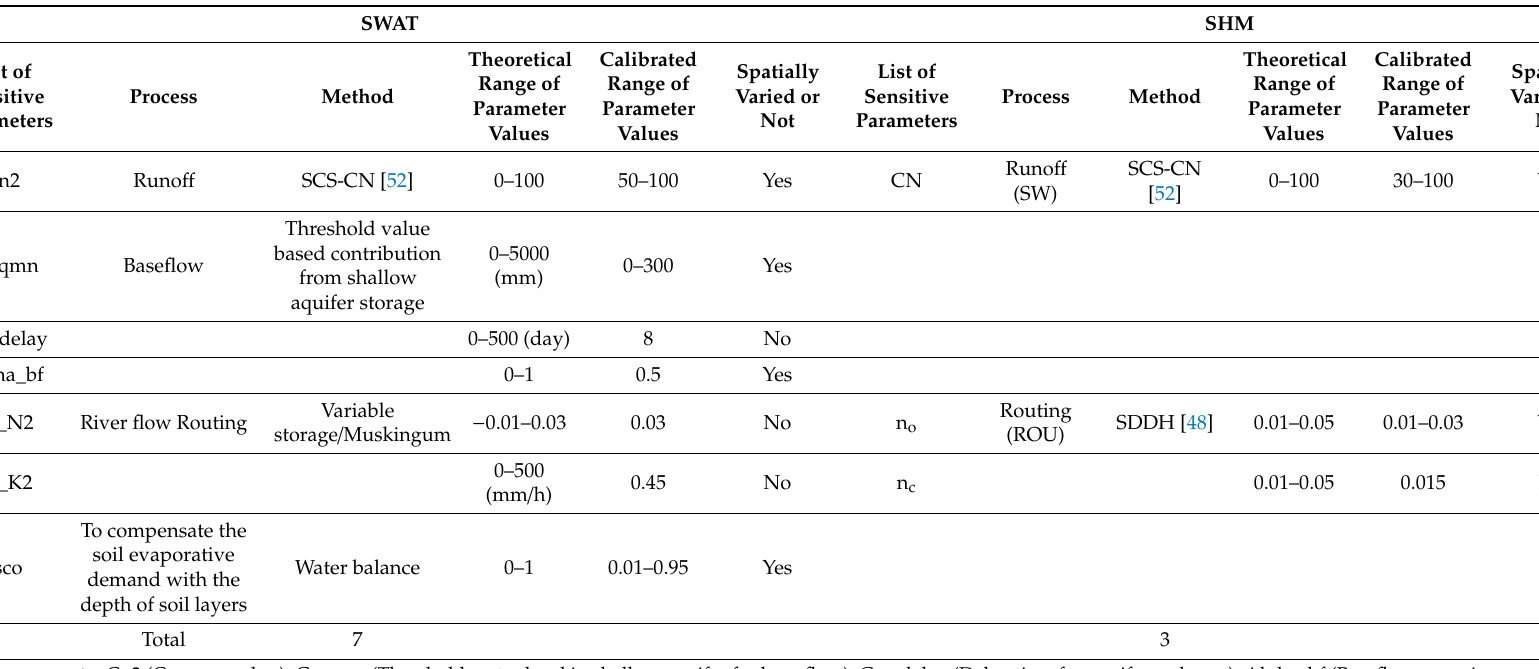
Table 1. Summary of the sensitive parameters, respective hydrological processes with methodology, theoretical range of their values and information on the spatial variation over the study area, used by SWAT and SHM to simulate hydrological